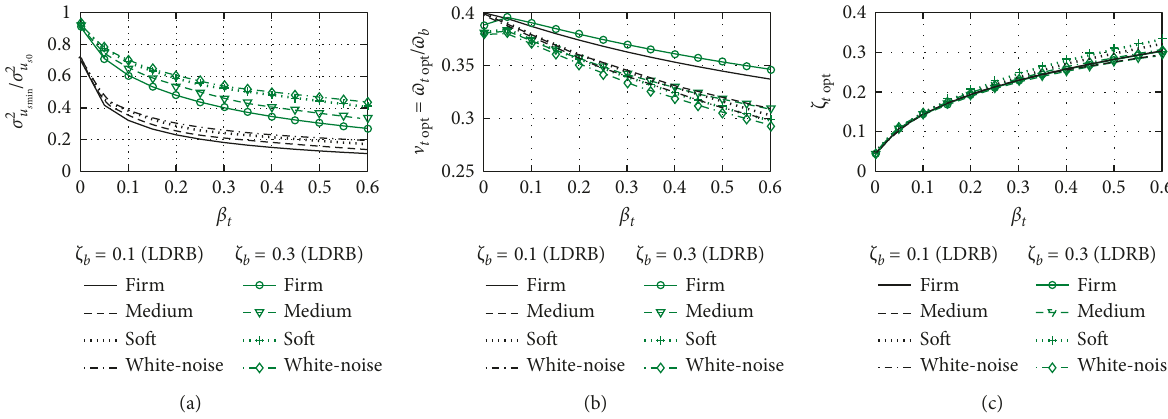
Figure 10: Optimal TMDI design for different BIS damping ratios and soil conditions: (a) minimum OF achieved, normalized with respect to the case without TMDI; (b) optimal frequency ratio; (c) damping ratio.